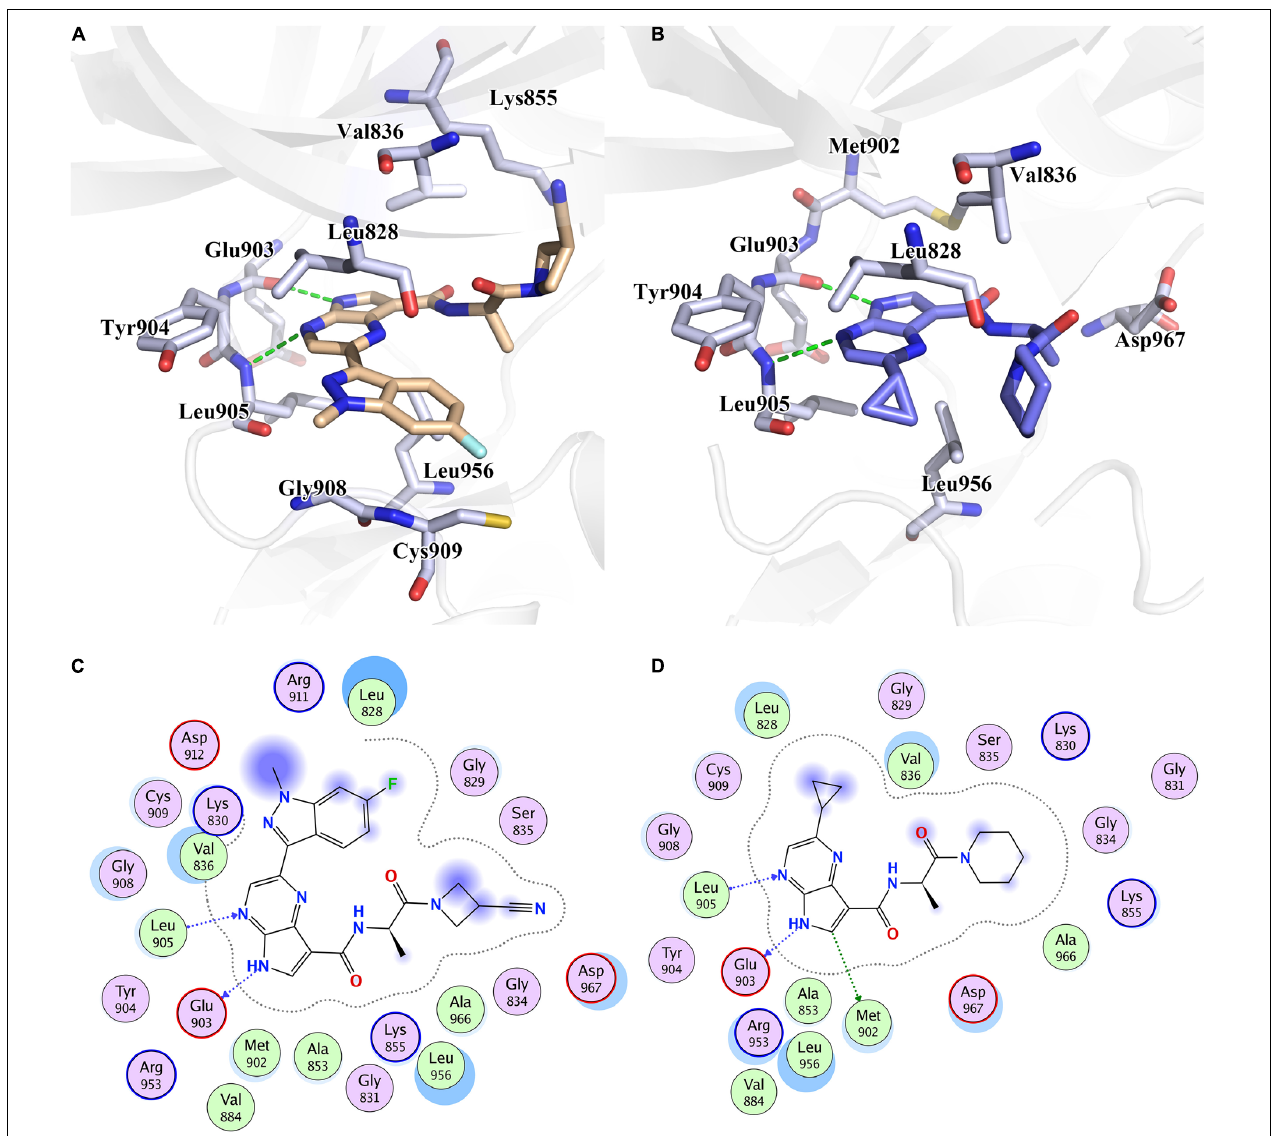
FIGURE 4 | The binding pattern of (A) Cpd61 and (B) Cpd10 with JAK3. 2D mode interactions of (C) Cpd61 and (D) Cpd10 with